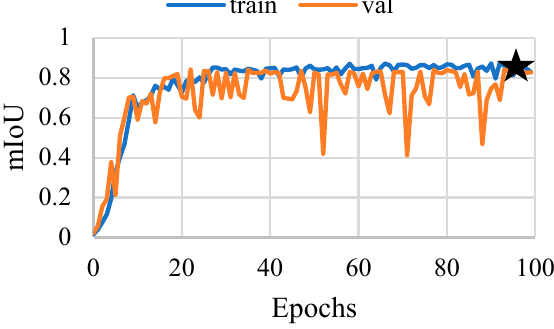
Figure 12. Training and validation mIoU at each epoch for U-Net with depth = 3; The best validation mIoU is achieved at epoch 97 with value of 84.09% (shown with the star symbol).